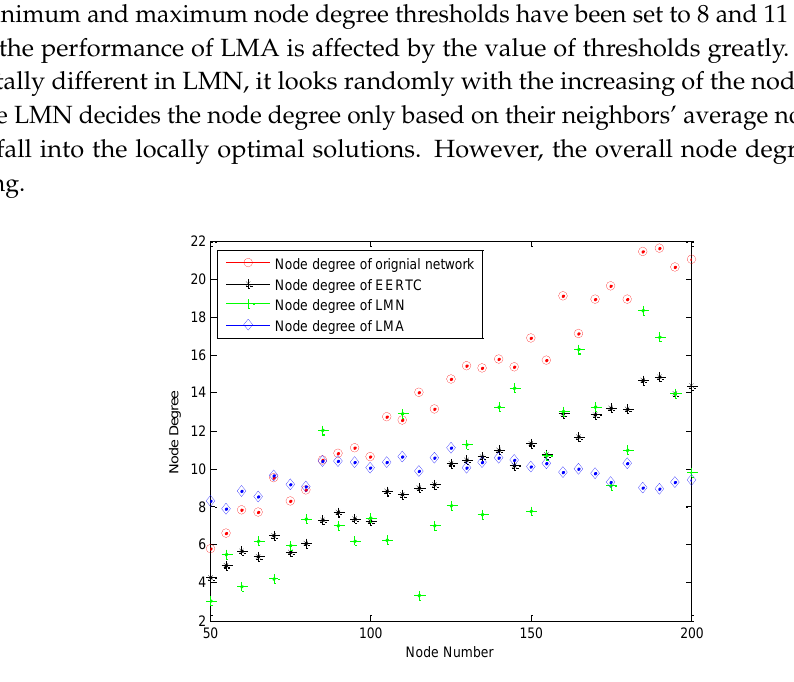
Figure 13. The energy consumption of different topology control protocols.